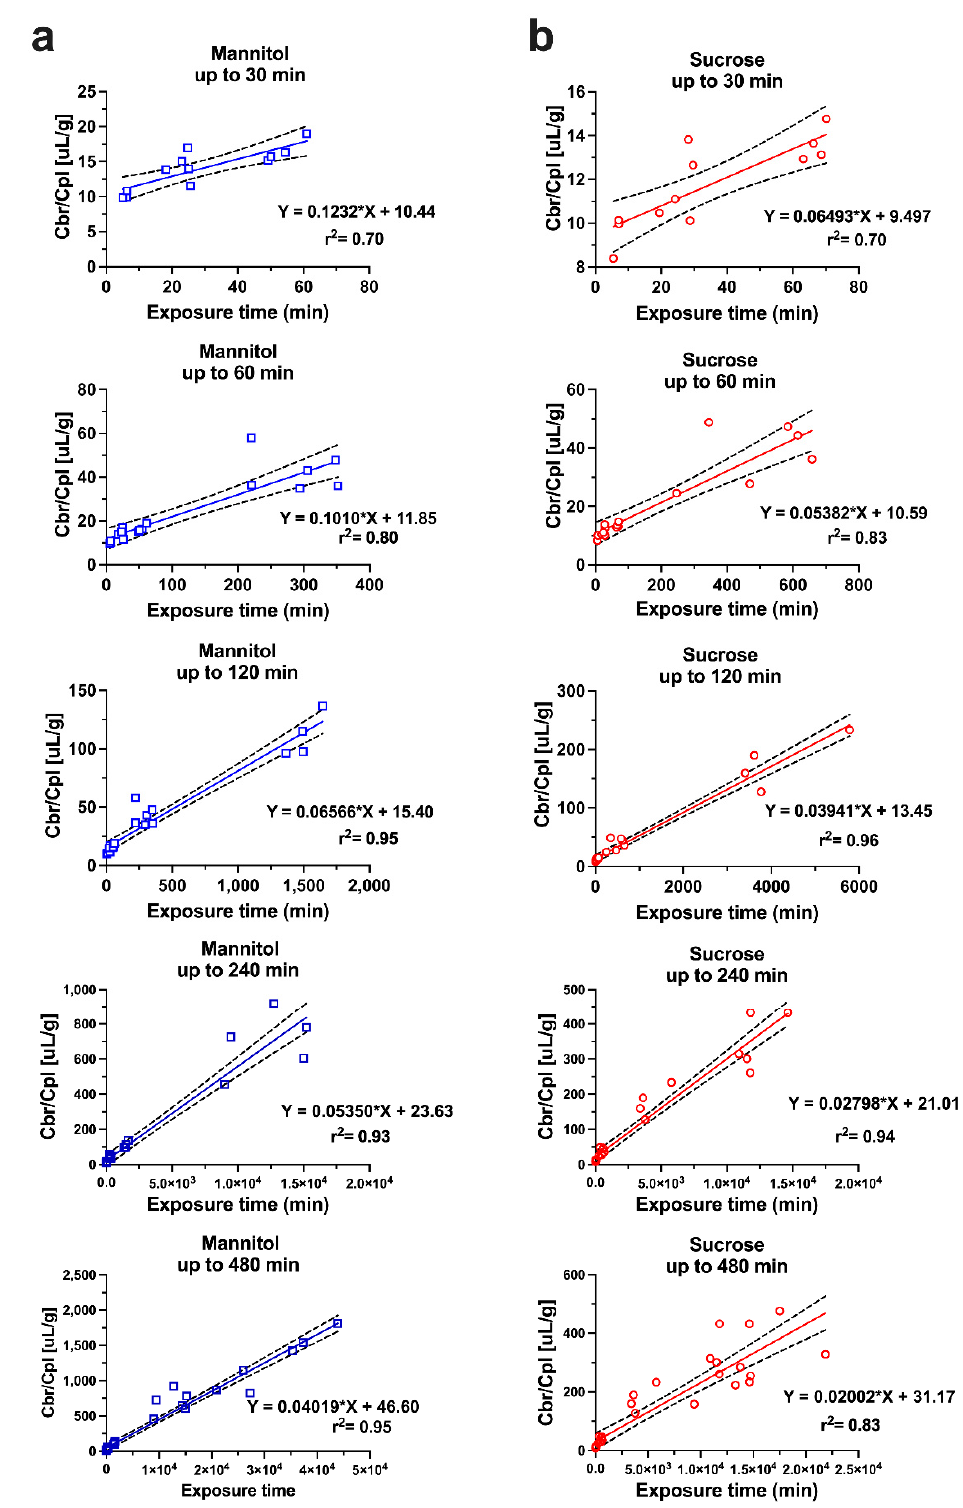
Figure 2. Multiple time point-analysis covering different sampling time points up to 480 min for ( a ) mannitol and ( b ) sucrose. Dashed lines represent the 95% confidence intervals. n = 4–7 animals per marker per time point. Reprinted with permission from Reference [19]. Copyright 2022, Springer Nature